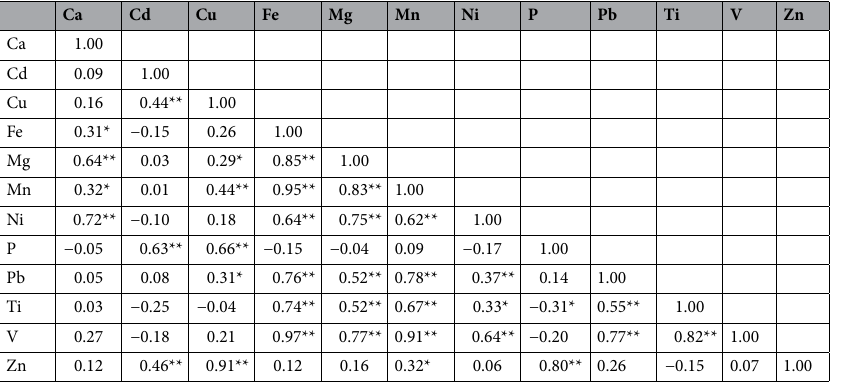
Table 3. Correlation coefficients matrix of elements (N = 48). Levels of significance: *p < 0.05. **p <